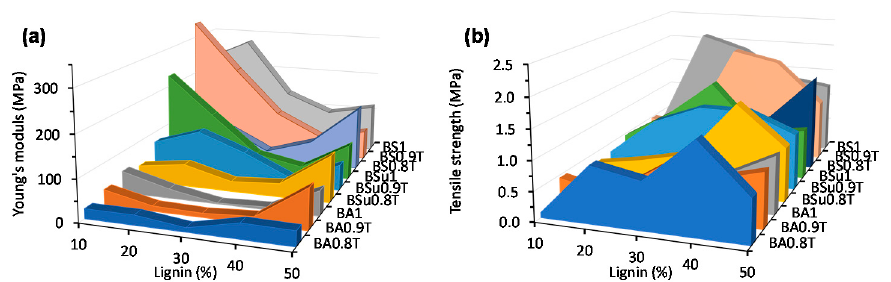
Figure 10. Plot of ( a ) Young’s modulus versus lignin content and ( b ) tensile strength versus lignin content for the various lignin-copolyester/amide formulations.